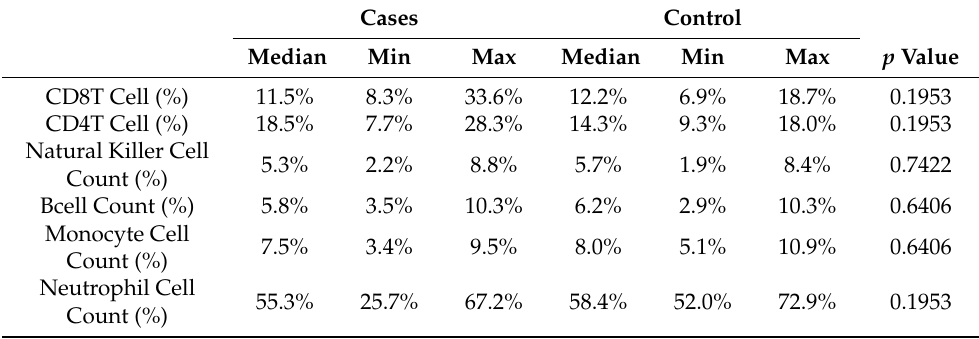
Table A1. Proportion of Blood Cell Populations in IS Cases and